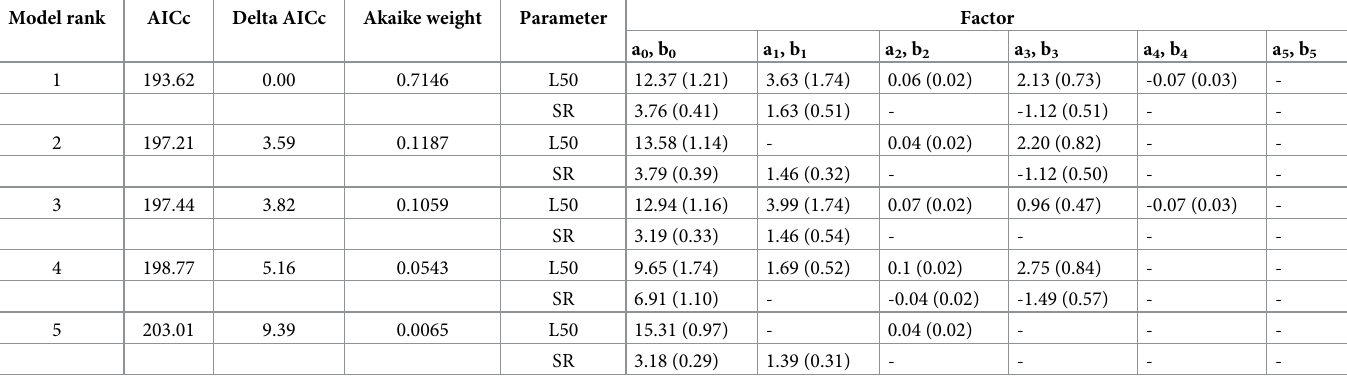
Table 9. Description and model ranking based on the full model (Eq 2) for deep-water rose